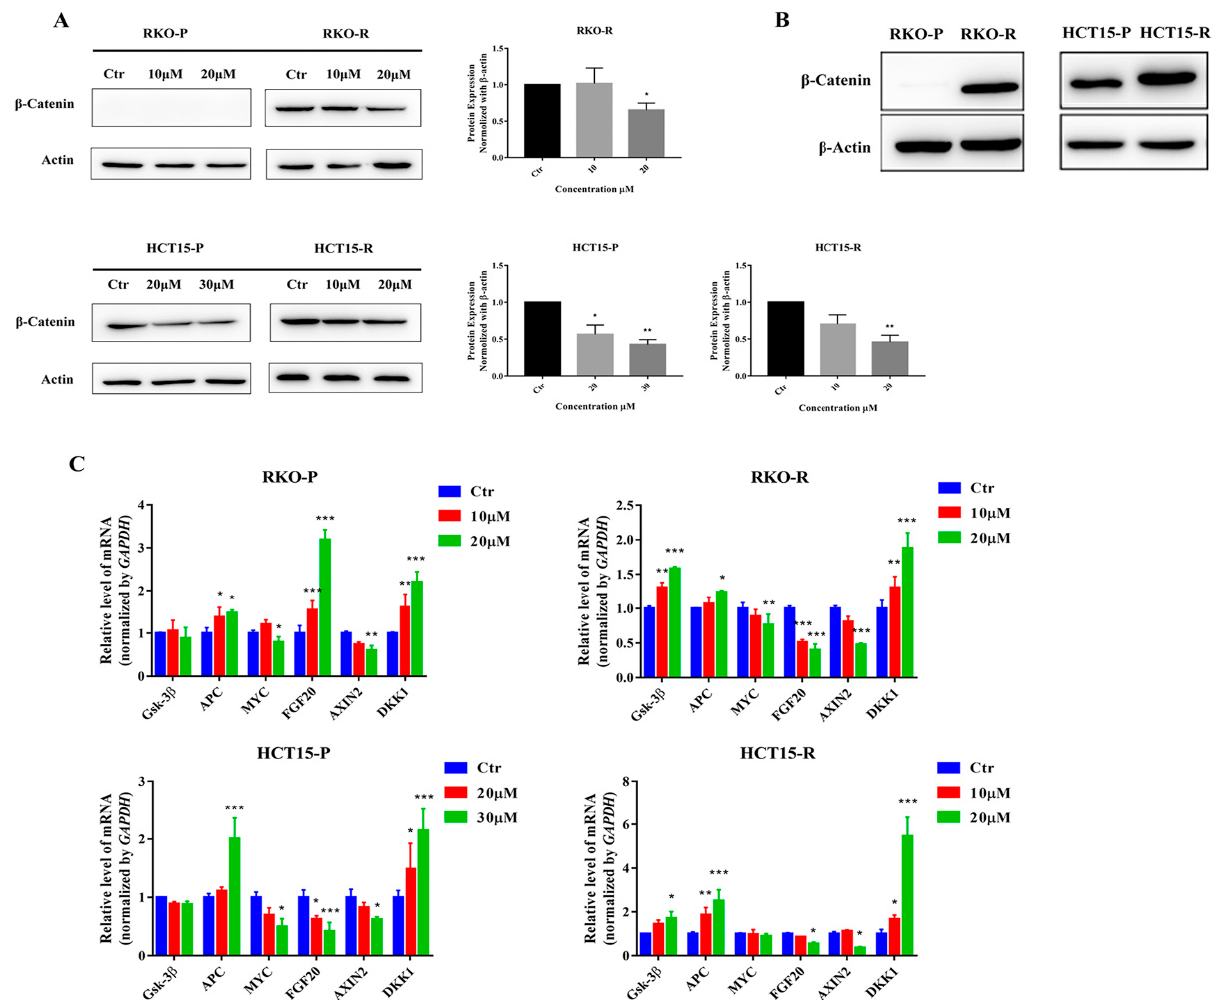
Figure 6. AGE inhibited Wnt signaling pathway in 5-FU-sensitive/resistant CRC cell lines. ( A ): The β -Catenin expression levels were measured and analyzed with β -Actin, and results are shown in the right diagram. As there is almost no expression of β -Catenin protein in RKO-P cells, there are no results for the RKO-P cells. ( B ): The expression levels of β -Catenin protein in the RKO-P/R and HCT15-P/R cells. ( C ): AGE regulated the expression levels of related to Wnt signaling pathway genes, such as Gsk 3 β , APC , MYC , FGF20 , AXIN2 , and DKK1 . Results are expressed as mean ± SD ( n = 3). * p < 0.05, ** p < 0.01, *** p < 0.001, compared with Ctr